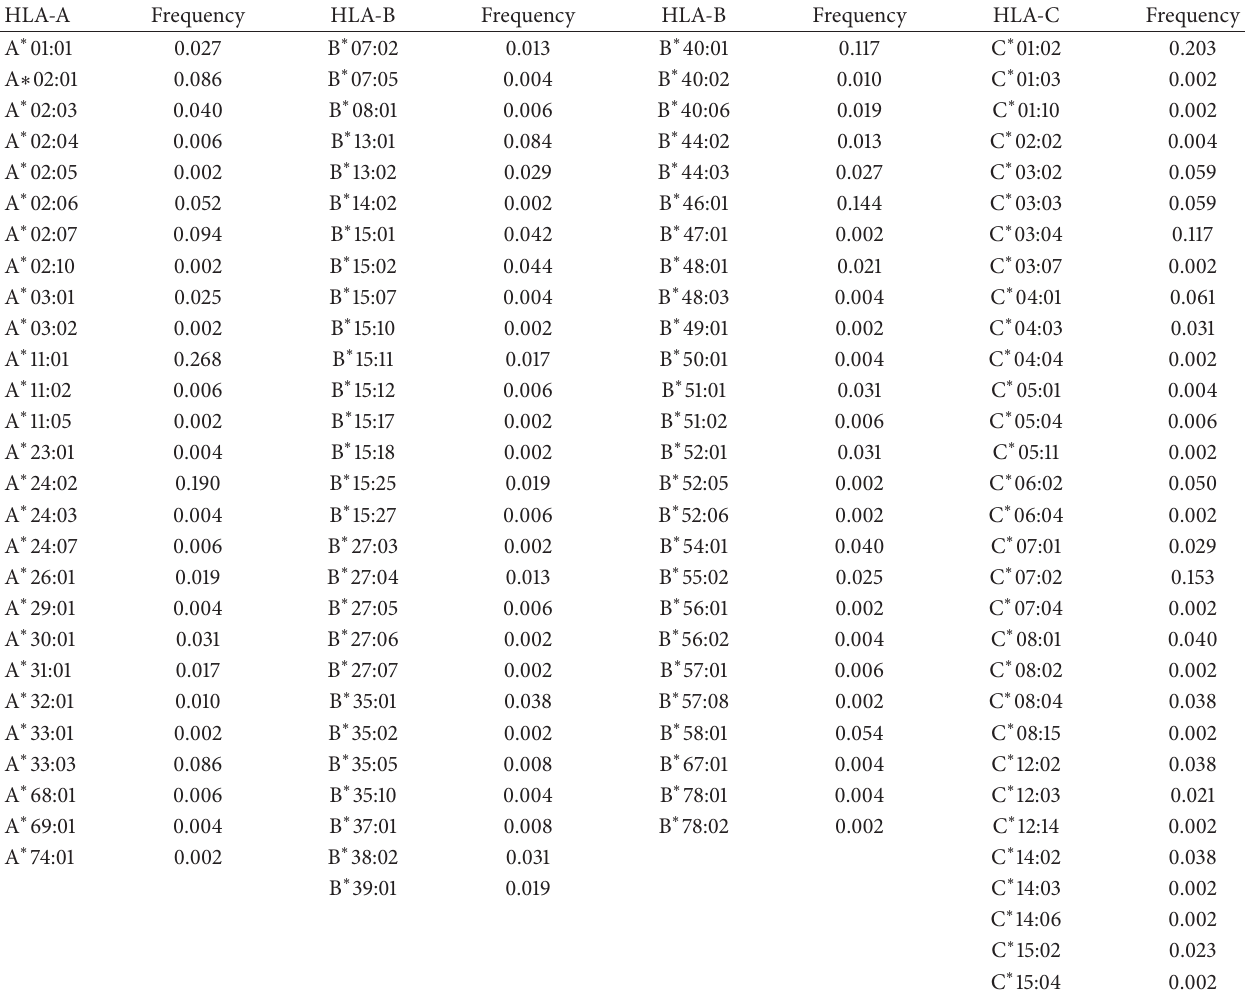
Table 2: HLA-A, HLA-B, and HLA-C allele frequencies in Yunnan Han. HLA-A Frequency HLA-B